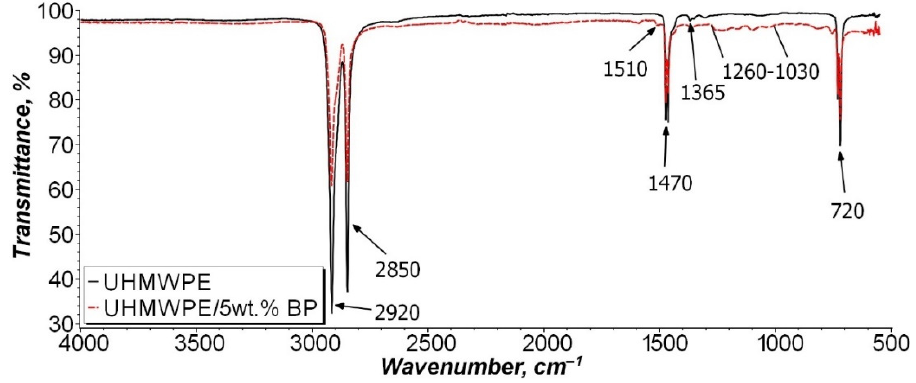
Figure 4. IR spectra of the initial UHMWPE and composite UHMWPE/5 wt. %